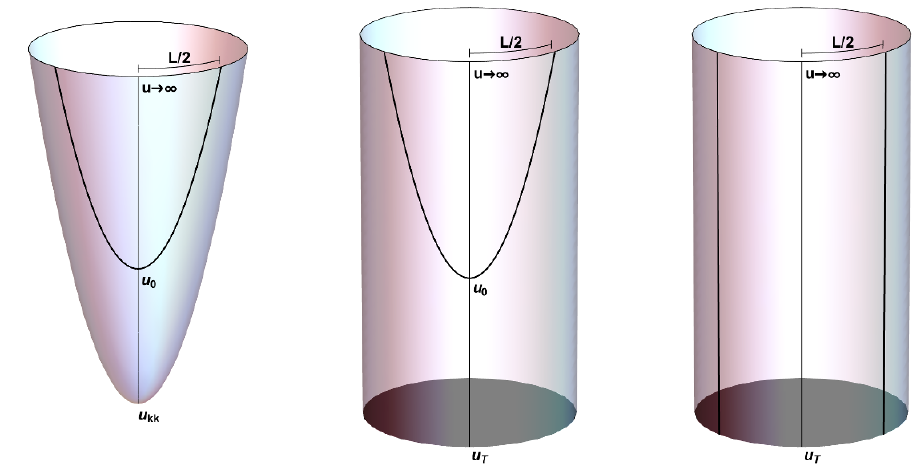
Figure 1 . Left (cid:12)gure: the con(cid:12)ned geometry where chiral symmetry breaking is guaranteed, with the D 8/ D 8 branes joining at radial position u 0 . Middle (cid:12)gure: the decon(cid:12)ned phase, also with chiral symmetry breaking, which only happens for non-antipodal brane con(cid:12)gurations. Right (cid:12)gure: the decon(cid:12)ned phase with chiral symmetry